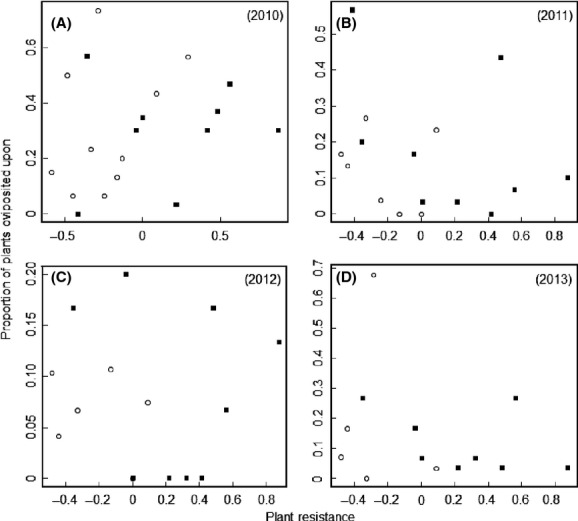
Relationship between plant resistance and the proportion of plant individuals in tetraploid (filled squares) and octoploid (open circles) populations of Cardamine pratensis oviposited upon by the butterfly herbivore Anthocharis cardamines in (A) 2010 (19 populations), (B) 2011 (16 populations), (C) 2012 (15 populations), and (D) 2013 (13 populations). Resistance was calculated by standardizing the time it took for a plant to receive an egg in a contextually controlled cage experiment by subtracting the mean oviposition time and dividing it by the standard deviation of the trial (for details see König et al. 2014a). Negative values of resistance represent low resistance against oviposition and positive values represent high resistance. None of the relationships are significant at P = 0.05.